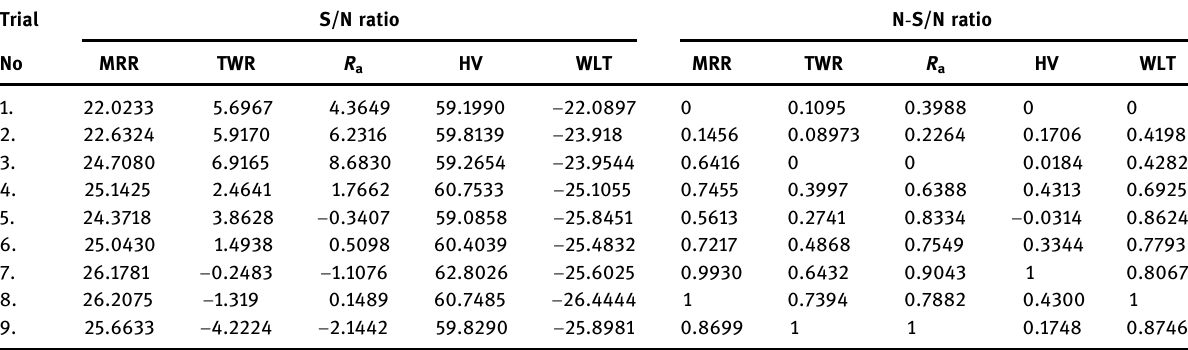
Table 3: Normalized ratio of the present study Trial